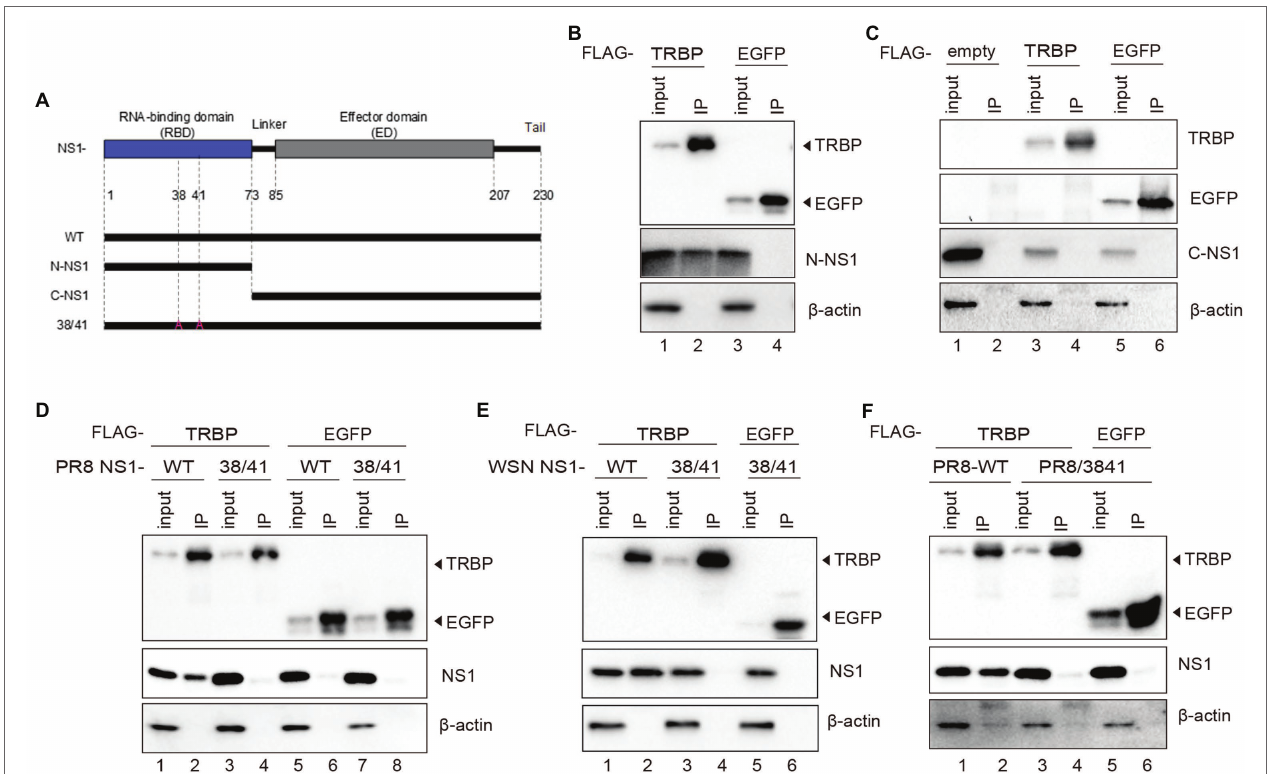
FIGURE 3 | R38A and K41A mutations in NS1 abolish the NS1-TRBP interaction. (A) Domain architecture of PR8 NS1 protein (NS1-WT) and the generated mutant constructs (N-NS1, C-NS1, NS1 38/41). (B) Immunoprecipitation of N-NS1 protein with the TRBP protein. Plasmids encoding FLAG-TRBP or FLAG-EGFP and N-NS1 were co-transfected into 293 T cells for 48 h. Immunoprecipitations were performed with anti-FLAG antibody. FLAG-tagged proteins, N-NS1, and β -actin were detected with specific antibodies. (C) Immunoprecipitation of C-NS1 protein with the TRBP protein. Plasmids encoding FLAG-TRBP or FLAG-EGFP and C-NS1 were co-transfected into 293 T cells for 48 h and processed as in (B) . (D) Plasmids encoding FLAG-TRBP or FLAG-EGFP and PR8 NS1-WT or PR8 NS1 38/41 were co-transfected into 293 T cells for 48 h and processed as in (B) . (E) Plasmids encoding FLAG-TRBP or FLAG-EGFP and WSN NS1-WT or WSN NS1 38/41 were co-transfected into 293 T cells for 48 h and processed as in (B) . (F) 293 T cells were transfected with FLAG-TRBP or FLAG-EGFP for 24 h before infected with PR8-WT (MOI = 1) or PR8/3841 (MOI = 1) for 24 h and processed as in (B)